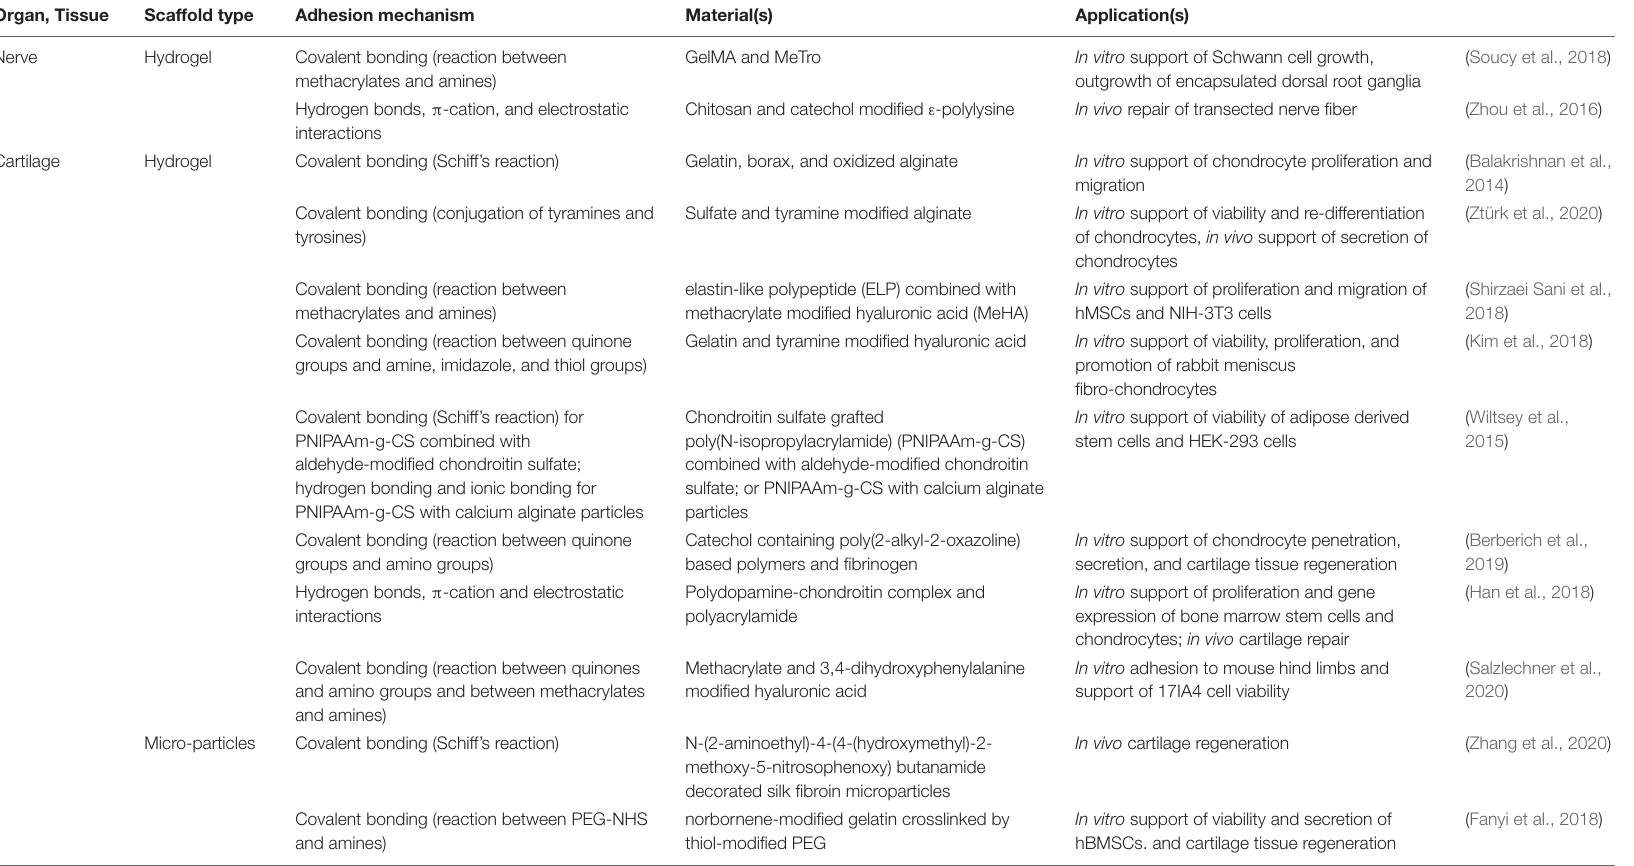
TABLE 2 | List of various adhesive tissue engineering scaffold (ATES) systems along with the scaffold type, adhesion mechanism, and applications. Organ,